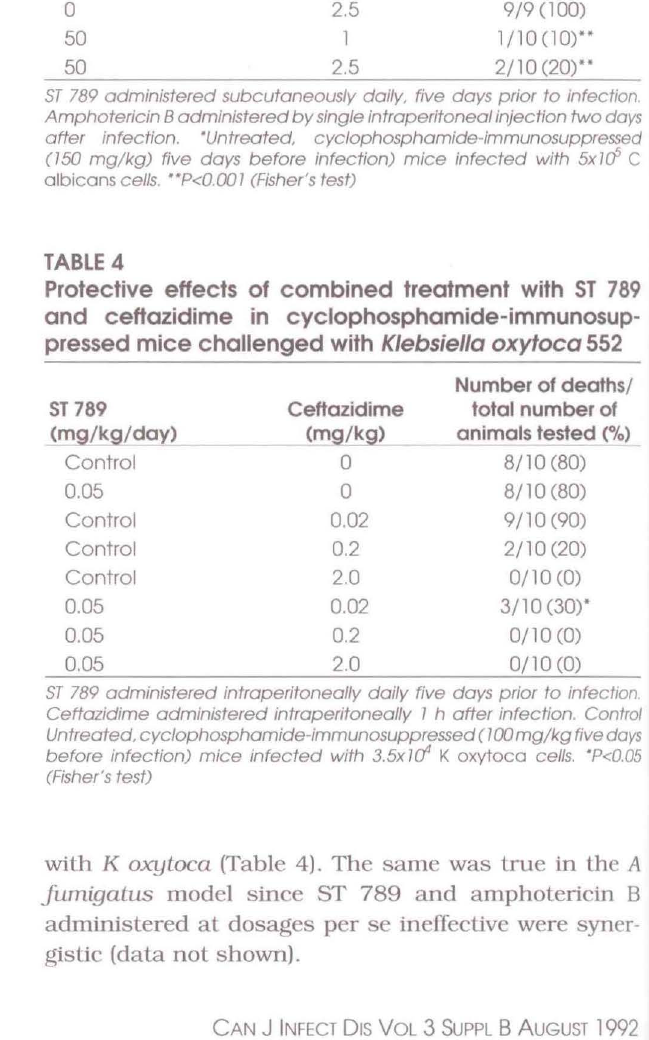
Protective effects of combined treatment with ST 789 and amphotericin B in cyclophosphamide-immunosup